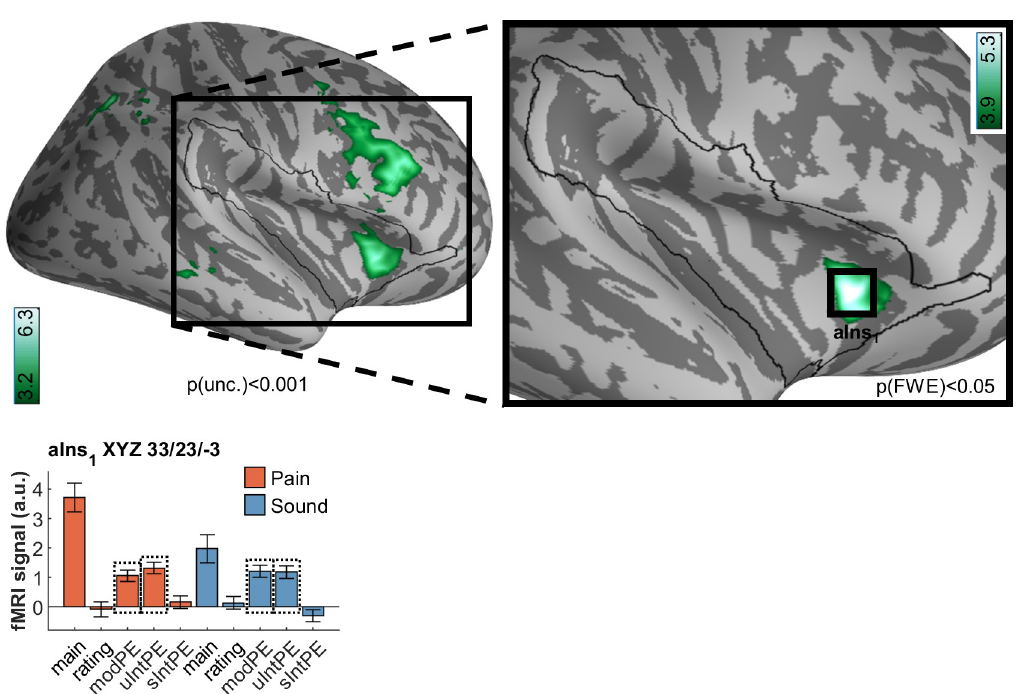
Fig 8. Common brain activation associated with unsigned intensity and modality prediction errors. The fMRI signal plot shows that the peak in the anterior insula (aIns 1 ) encodes PEs for every contrast included in the conjunction. Activations are overlaid on an average brain surface; for display purposes, activations in the whole brain lateral view are thresholded at p [uncorr.] < 0.001. The black line in the zoomed-in view delineates the region of interest and includes activations within the small volume FWE corrected at p[corr.] < 0.05. In the fMRI signal bar graph, black rectangles highlight the regressors used for analysis; solid line indicates analysis with the respective individual regressor, and dashed line indicates conjunction analysis. fMRI signal labels refer to the regressors used for each modality: “main” for main effects of modality, “ratings” for behavioral ratings, “modPE” for modality PEs, “uIntPE” for unsigned intensity PEs, and “sIntPE” for signed intensity PEs. Data used to produce the figure can be found at https://www.doi.org/10.17605/OSF.IO/7JBV3. fMRI, functional magnetic resonance imaging; FWE, family-wise error; PE, prediction